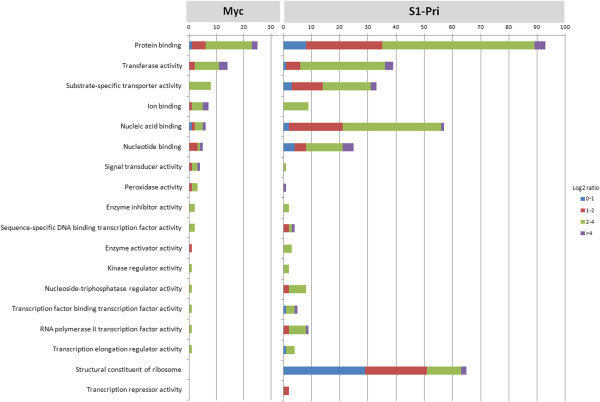
Assignment of DEGs to 18 selected Molecular Function in Gene Ontology. Both Myc and S1-Pri DEGs were assigned to Gene Ontology and 18 selected Molecular Functions are presented to show that gene sets involved in many important cellular activities such as transcription factor binding, DNA/RNA/protein binding, enzyme regulation, transcriptional activation/repression and translation had to be suppressed and induced simultaneously during fruiting body development.